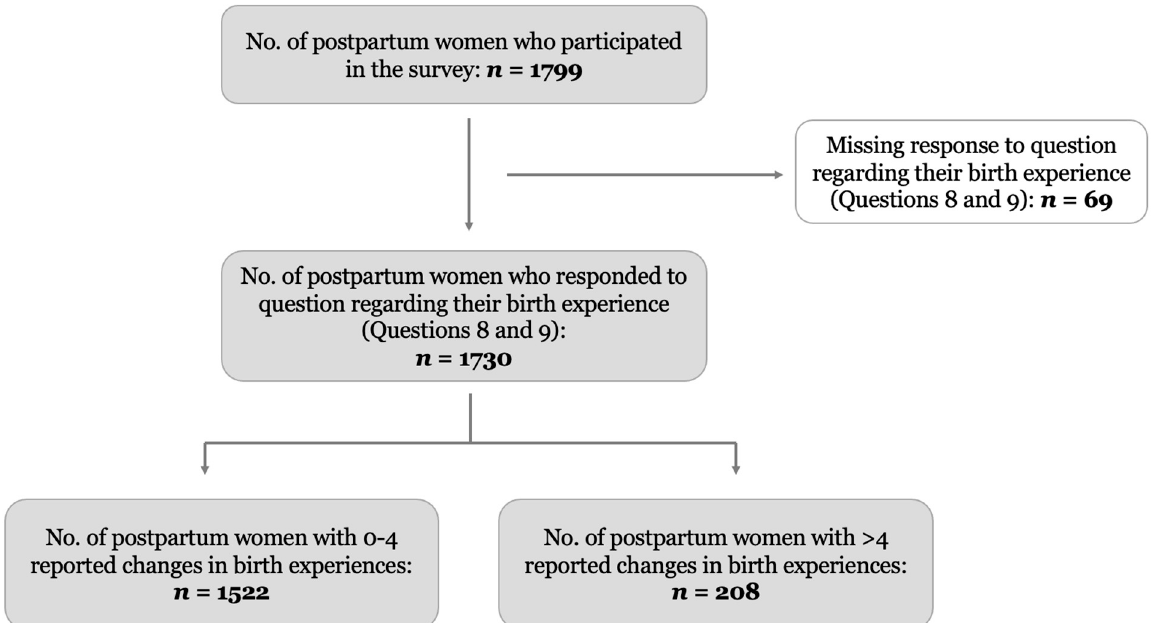
Figure 1. Flowchart of the study participants.